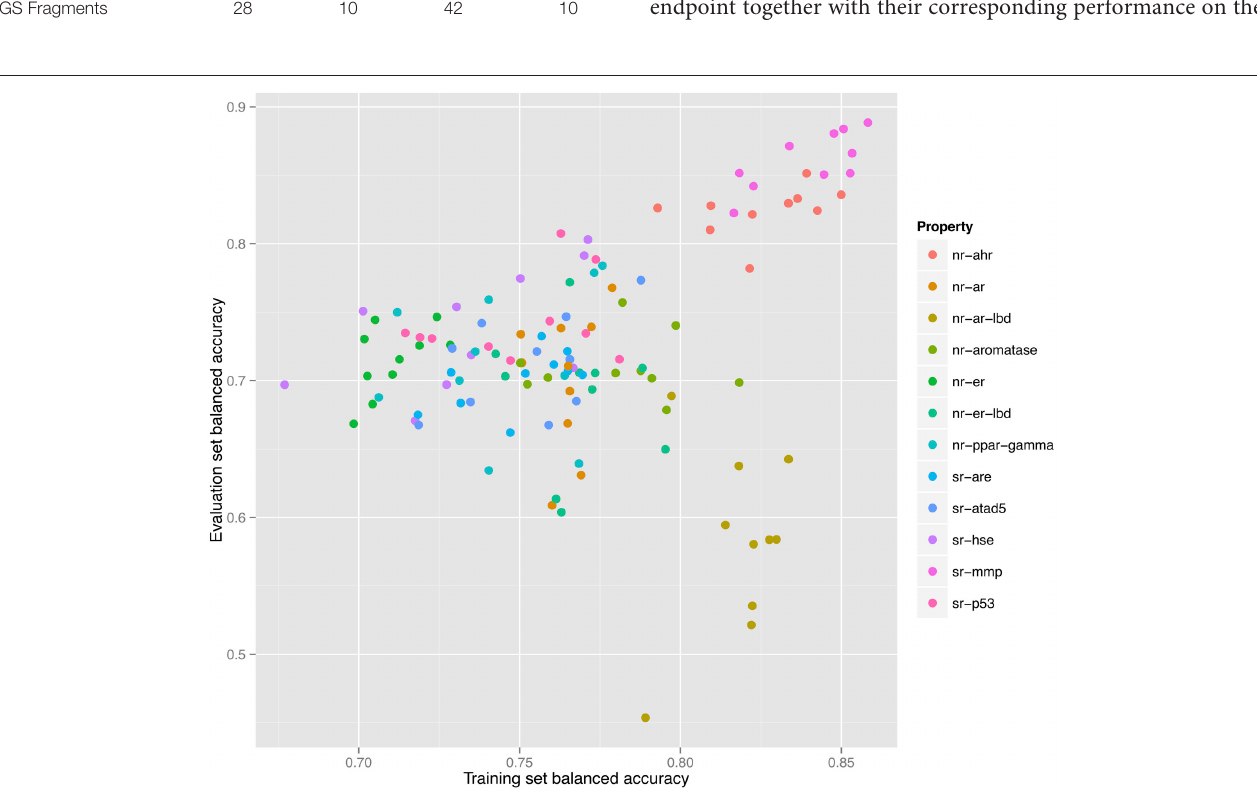
Frontiers in Environmental Science |